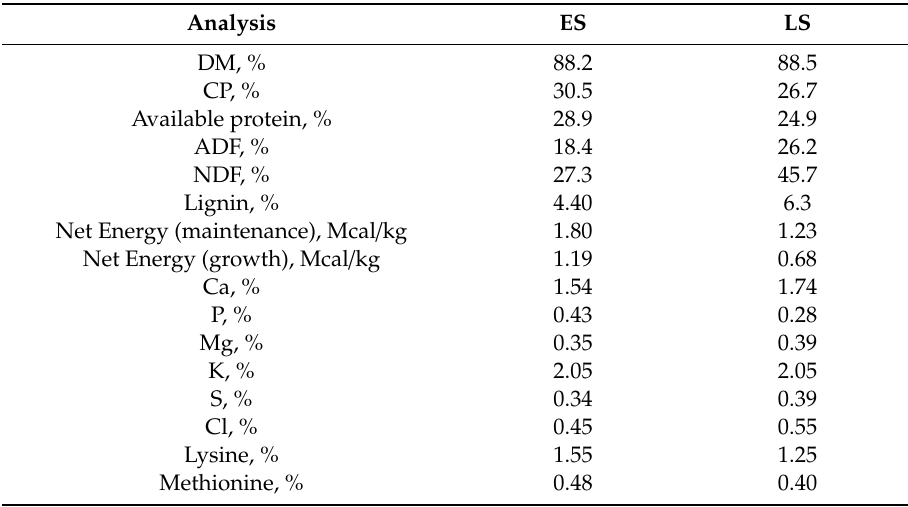
Table 7. Near infrared reflectance spectroscopy (NIR) chemical composition of early (ES) and late season (LS) kudzu ( P. montana ) leaves incubated in experimental fistulated bovine during in situ rumen degradation study periods (DM basis) [36].